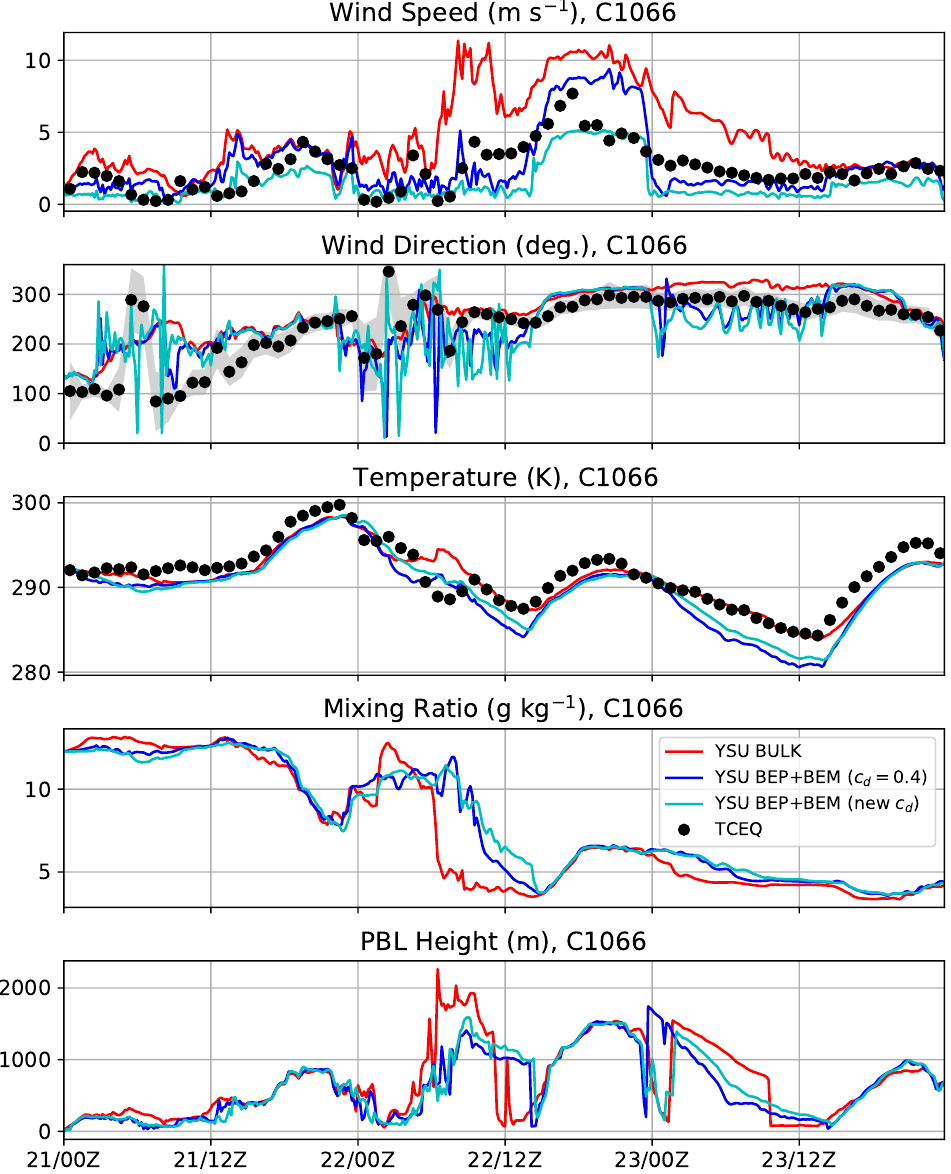
Figure 13. Same as Figure 7 but at COI station